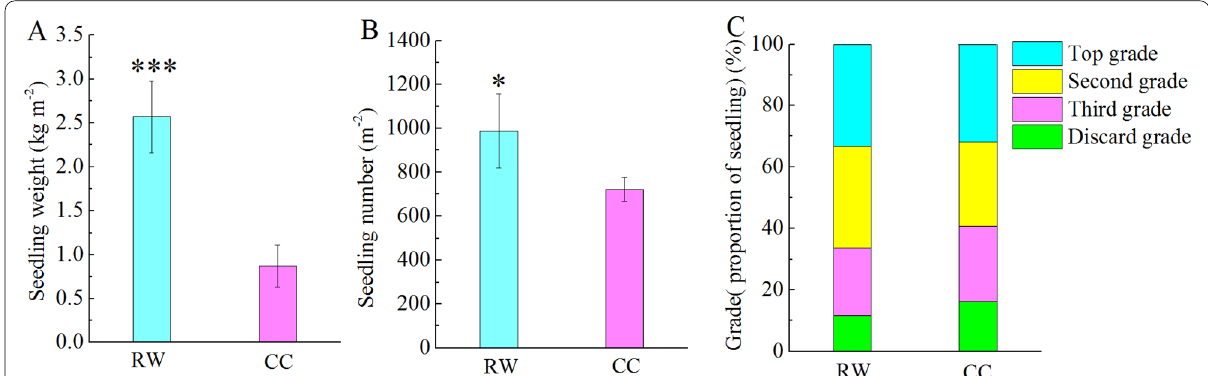
Fig. 1 Comparisons of the growth and grade proportion of A. sinensis seedlings between RW and CC. Significant differences were determined using least significant differences ( LSD 0.05) of the Student’s t -test after one-way ANOVA, n 5, (* P < 0.05; *** P < 0.001). A Seedling weight in RW ≤ = and CC. B Seedling numbers in RW and CC. C Grade proportion of seedling in RW and CC